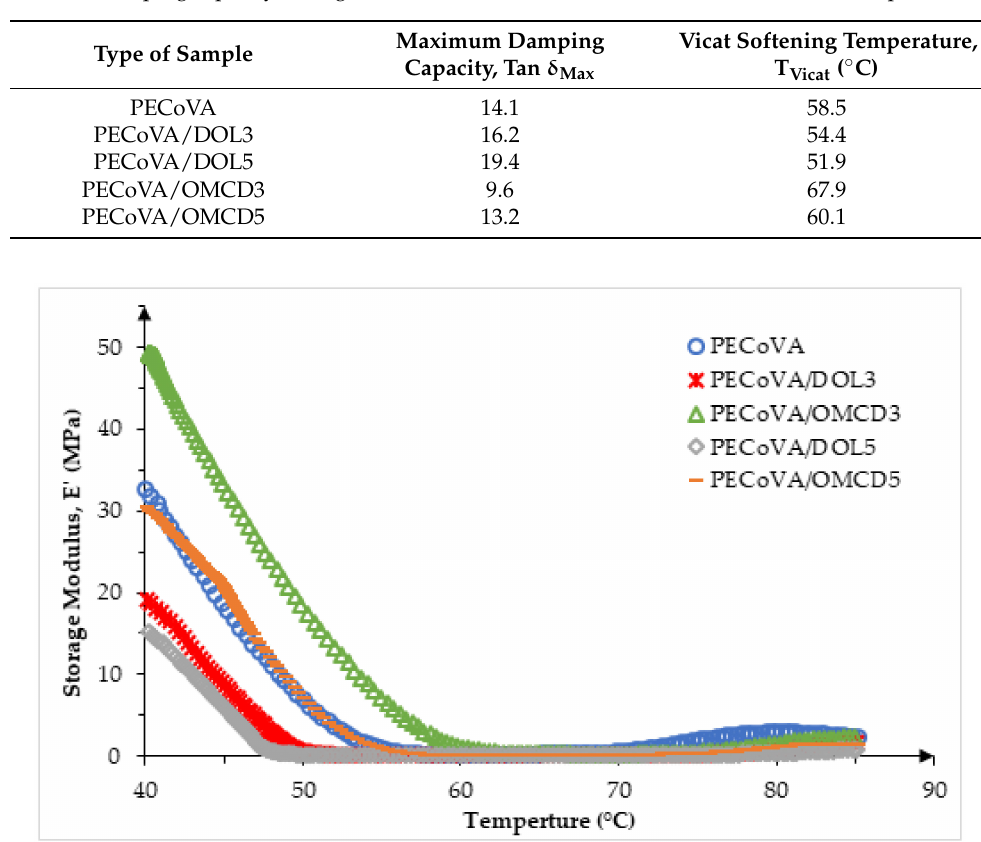
Figure 10. Effect of dolomite filler loading on the storage modulus, E’ of virgin PECoVA, PECoVA/DOL and PECoVA/OMCD